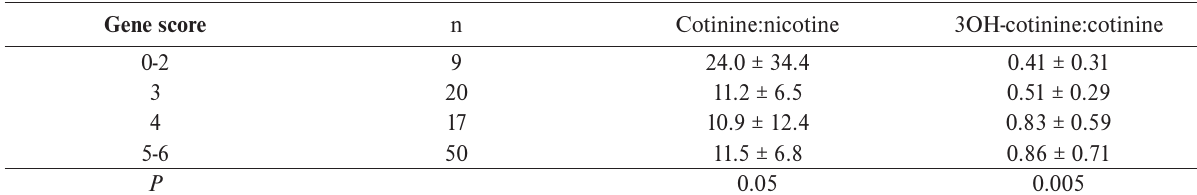
Table 3. Association between gene score (created from the rs4105144, rs3733829, rs6474412 and rs16969968 polymorphisms) and nicotine metabolite